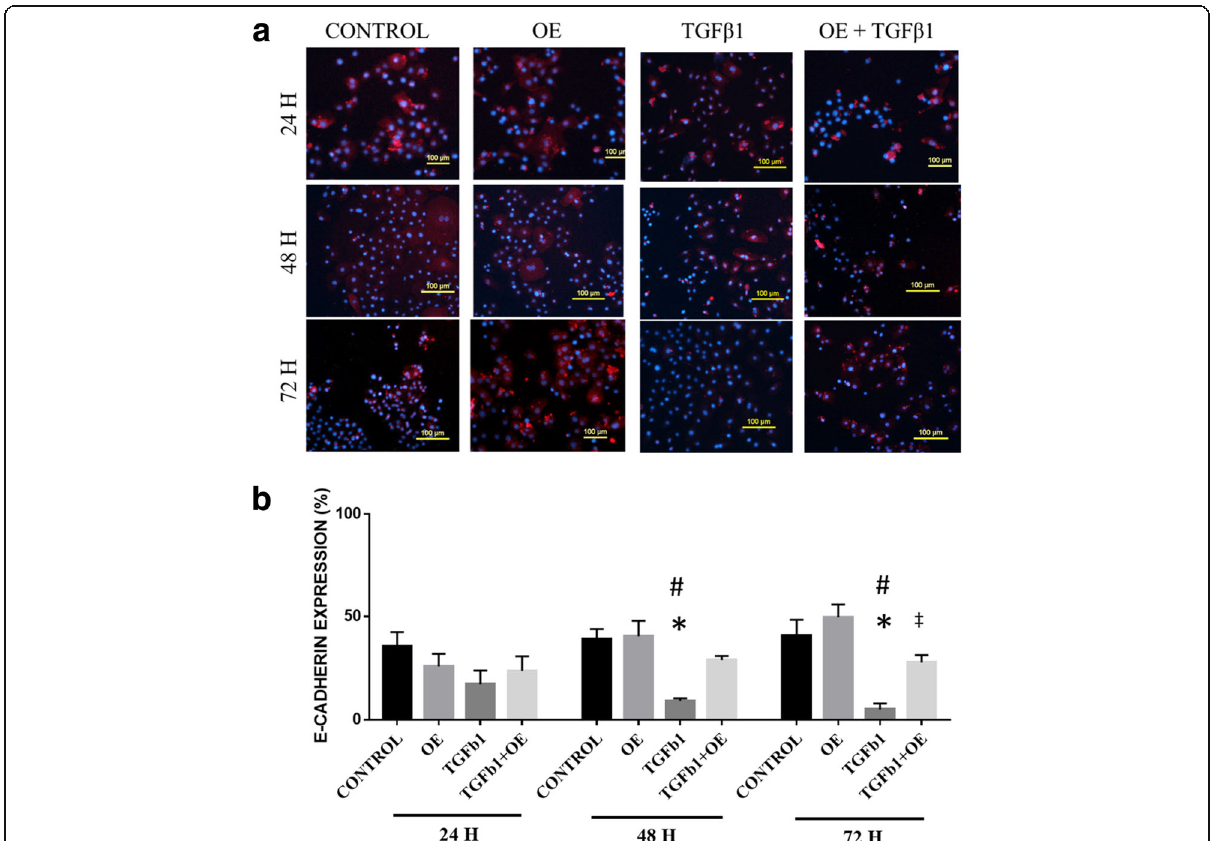
Fig. 6 a E-cadherin expression in untreated RECs (control), 0.05% OE-treated RECs (OE), RECs induced to EMT with 5 ng/ml TGF β 1 (TGF β 1) and RECs induced to EMT with TGF β 1 and treated with OE (TGF β 1 + OE) from 0 h until 72 h. Red colour indicates E-cadherin expression, and blue is the nucleus. b E-cadherin expression (%) at various time points. * P < 0.05 indicates significant differences when compared with the control, # P < 0.05 indicates significant differences when compared with OE, ‡ P < 0.05 indicates significant differences when compared with TGF β